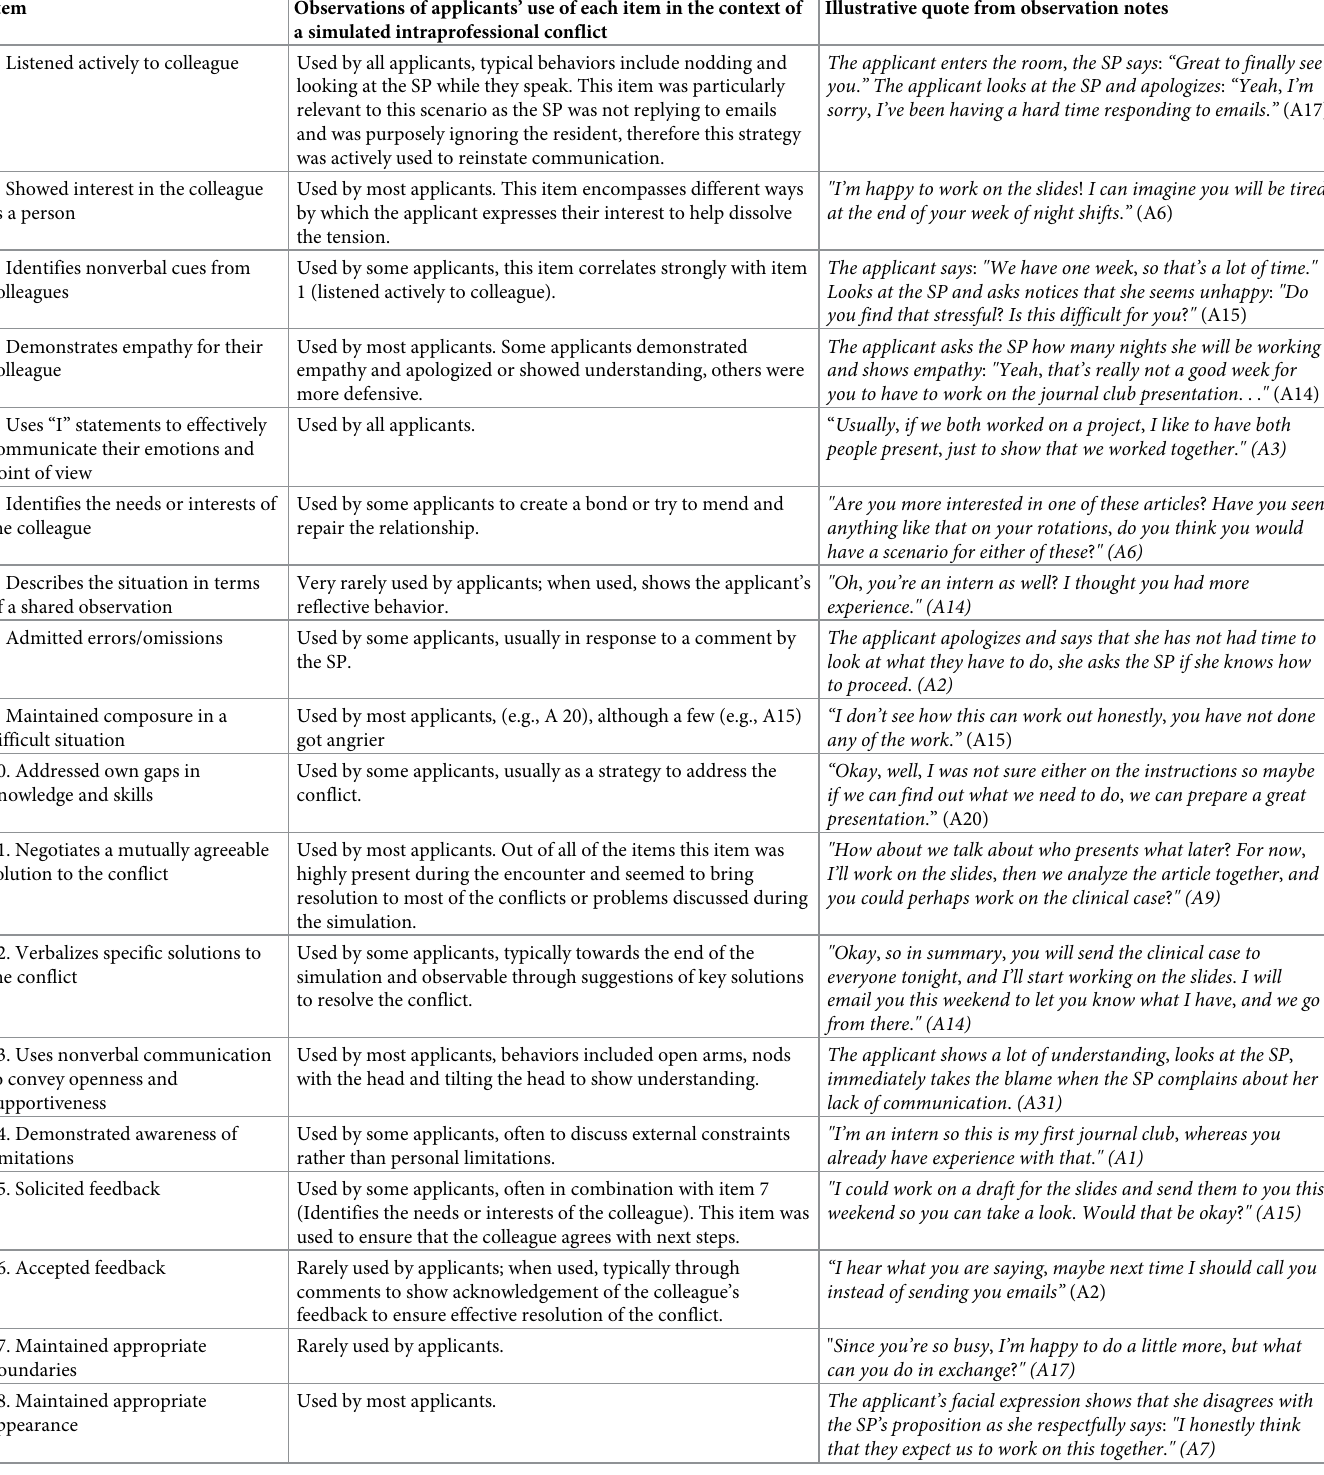
Table 1. Qualitative observations of the intraprofessional conflict exercise items.